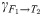
Counterfactual scenario that investigates the impact of increased switching rate to second line regimen.Simulations of the MARISA model from 2005 to 2016 under the scenarios where the switching rate to second-line regimen γF1→T2 is increased by factor 2, 5 and 10, represented respectively by the blue, red and yellow curves. In the baseline simulations represented by the black curves, a switching rate γF1→T2 of 1/2.9 years−1 is assumed for individuals with CD4<200 copies/μl. The following HIV outcomes are displayed: A) the number of newly infected per year, B) the total number of undiagnosed individuals at each year, C) the number of AIDS-related deaths per year and D) the percentage of infected individuals that are on ART, E) level NNRTI ADR and F) level of NNRTI TDR. Different colours correspond to different rates of starting treatment, where the rates are expressed as multiple of the rate in the standard model. The coloured circles and vertical lines at the right of each sub-figure correspond to the point estimates and 100% sensitivity ranges in 2016, respectively.